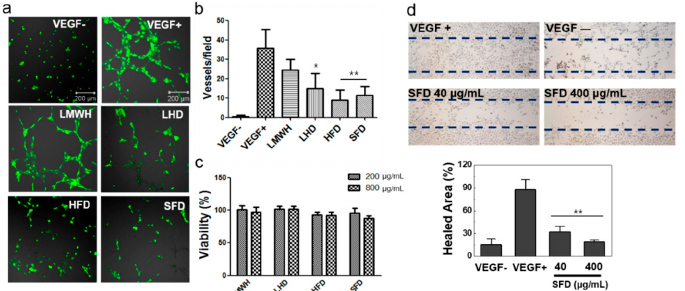
Figure 4. Inhibition of angiogenesis by heparins and SFD in the human umbilical vein endothelial cell (HUVEC) assay. ( a ) In vitro tubular formation of the HUVECs is presented after Calcein-AM treatment. ( b ) The number of vessels on the HUVECs was measured in the presence of LMWH, LHD, HFD, or SFD ( n = 4). ( c ) The cytotoxicity test (CCK assay) demonstrated that the heparin conjugates and SFD had no cytotoxic effect on the cells ( n = 6). ( d ) The VEGF-mediated wound healing assay showed that SFD can inhibit endothelial cell migration into the wound. The relative healed wound area was measured after toluidine blue treatment by using the ImageJ program (U.S. National Institutes of Health) ( n = 3). * p < 0.05 vs. control group; ** p < 0.01 vs. control group.